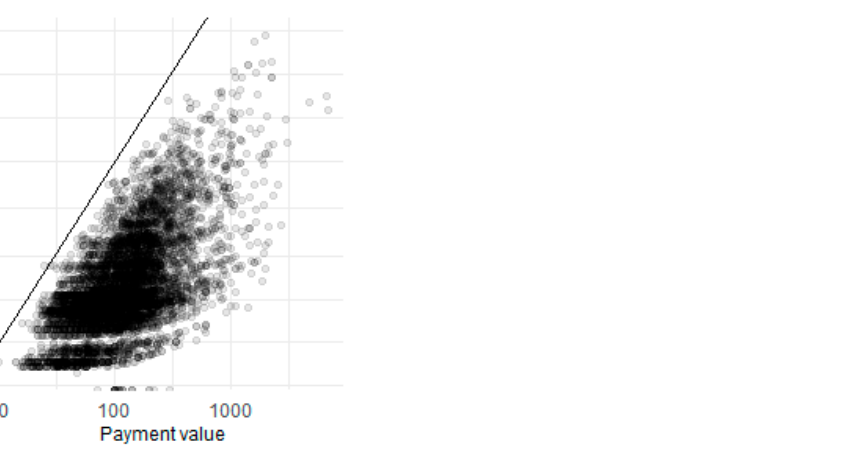
used for better plot clarity.